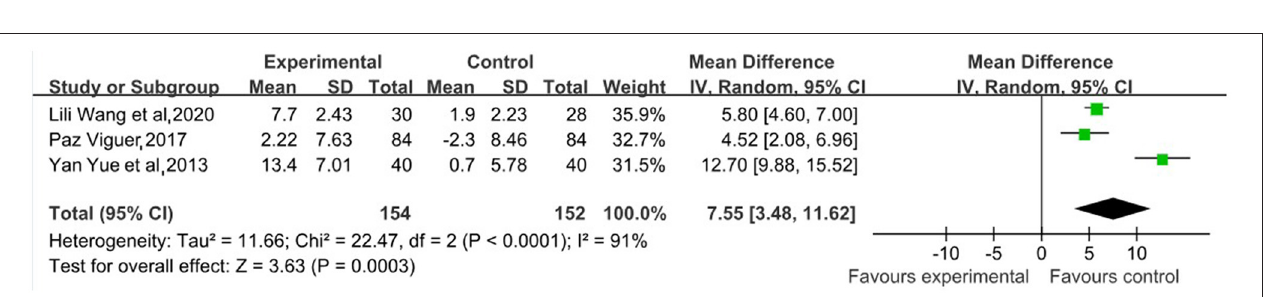
FIGURE 4 | Forest plot of the effect of group and individual reminiscence therapy on relieving depression symptoms.